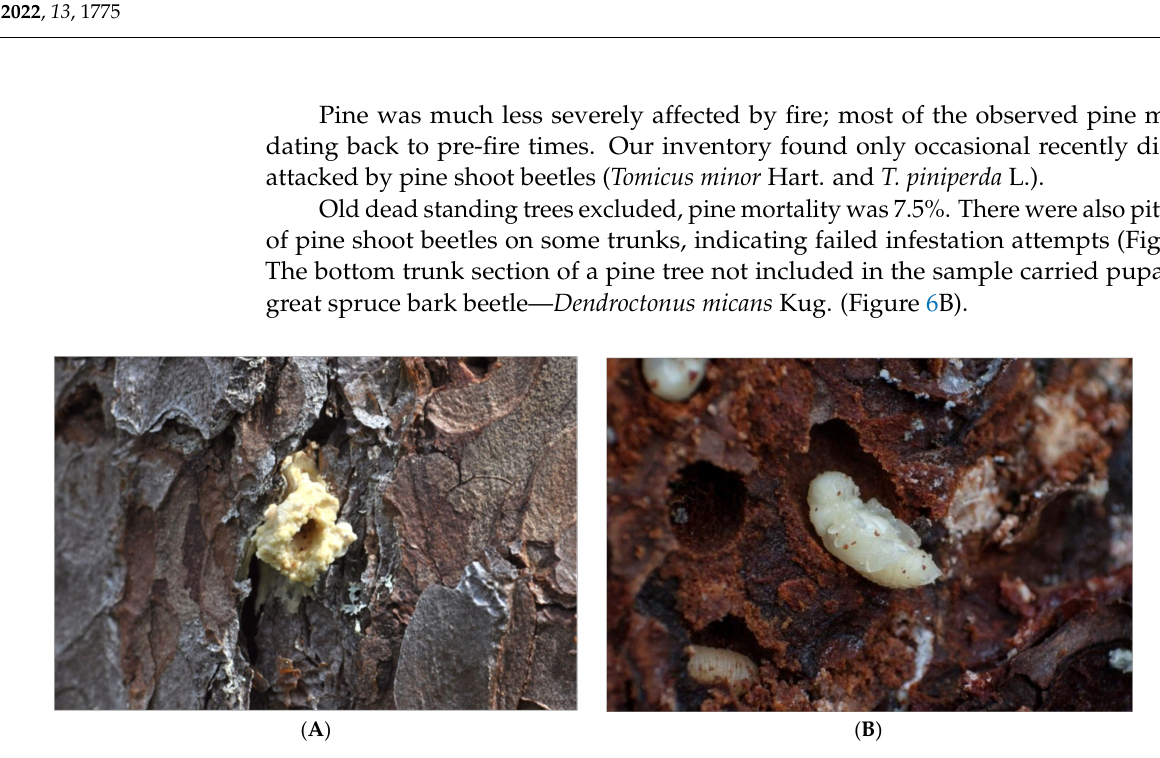
Figure 6. Pine tree infestation attempts: ( A )—pitch tube of a pine shoot beetle; ( B )— Dendroctonus micans pupa.